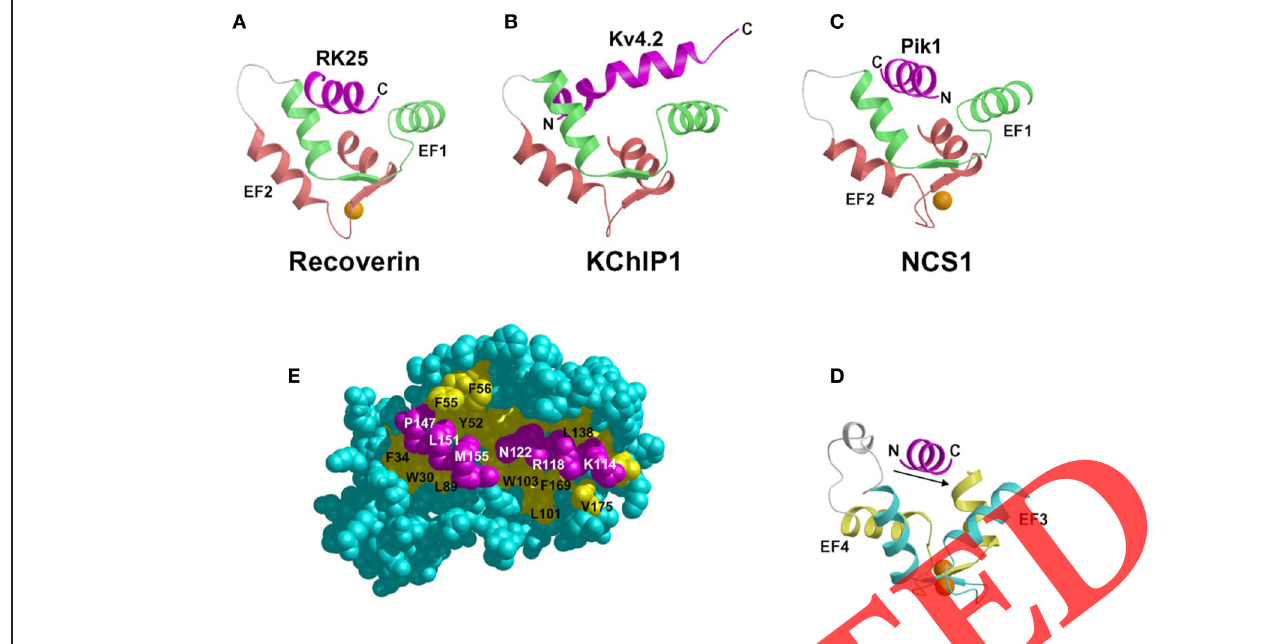
bound to Pik1(111–151) (E). In each case, a target helix (magenta) is inserted in groove formed by the helices of the EF-hands. The intermolecular interactions are mostly hydrophobic as described in the